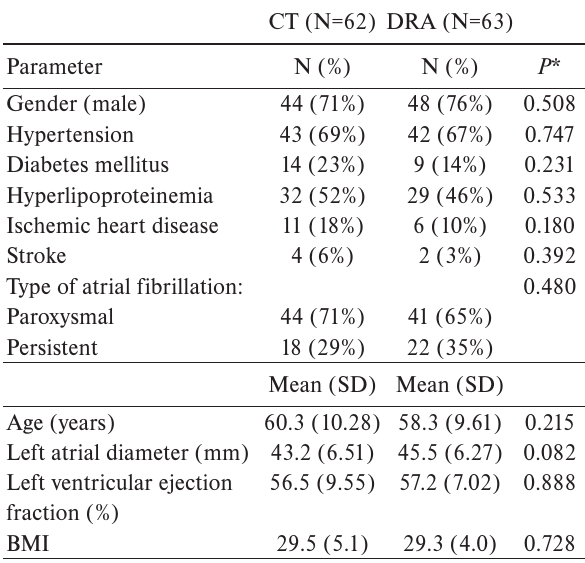
Table 1. Patients’ characteristics.